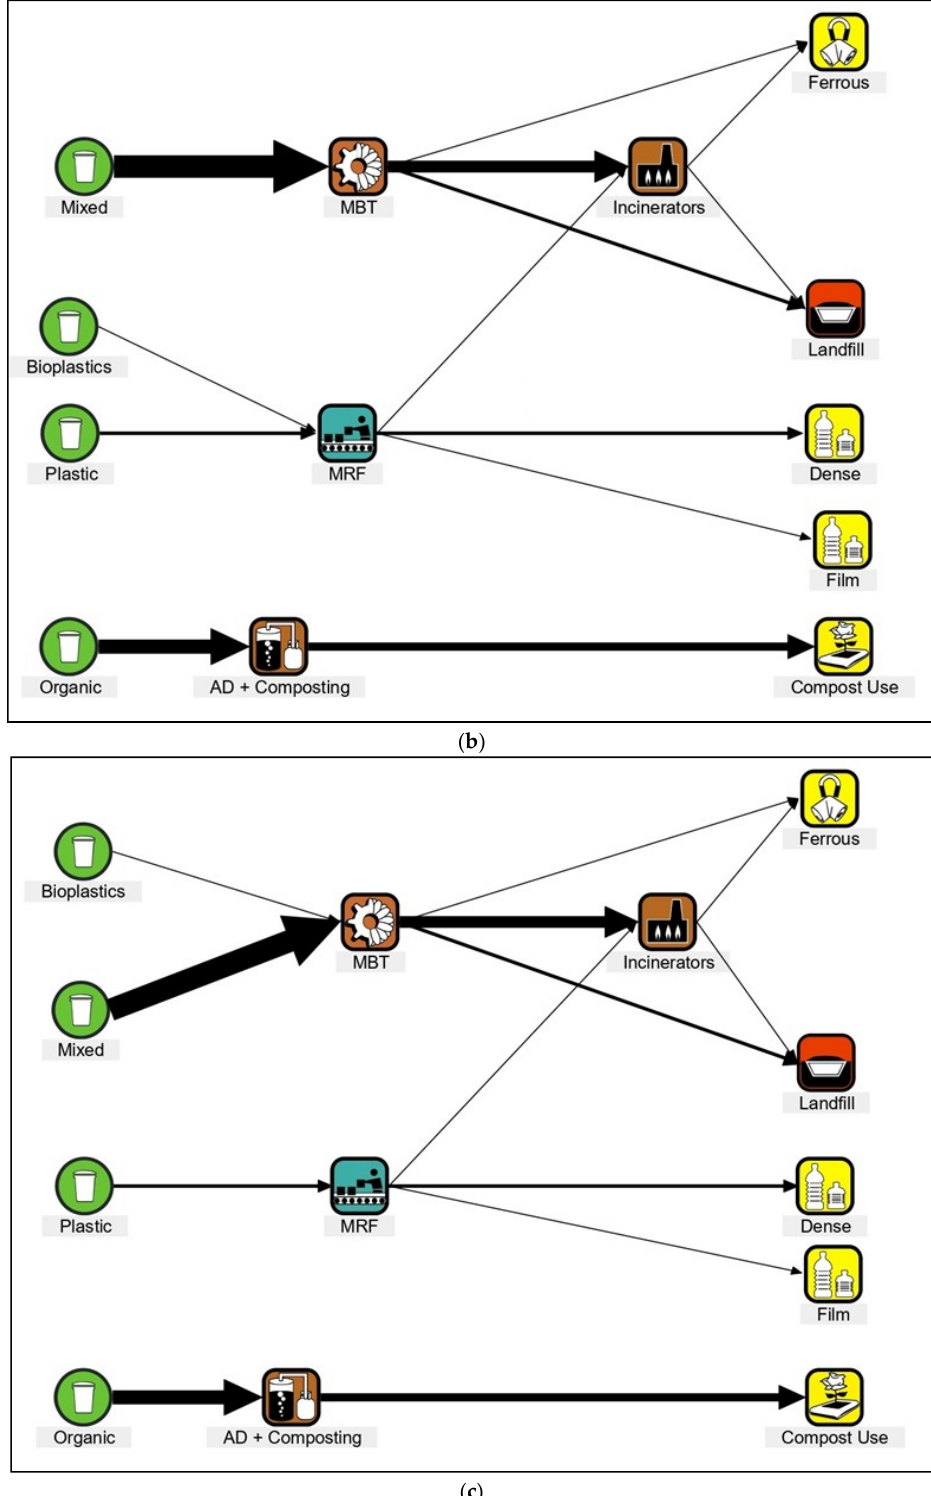
Figure 2. Mass inventory of organic ( a ), plastic ( b ) and mixed ( c ) waste treatment